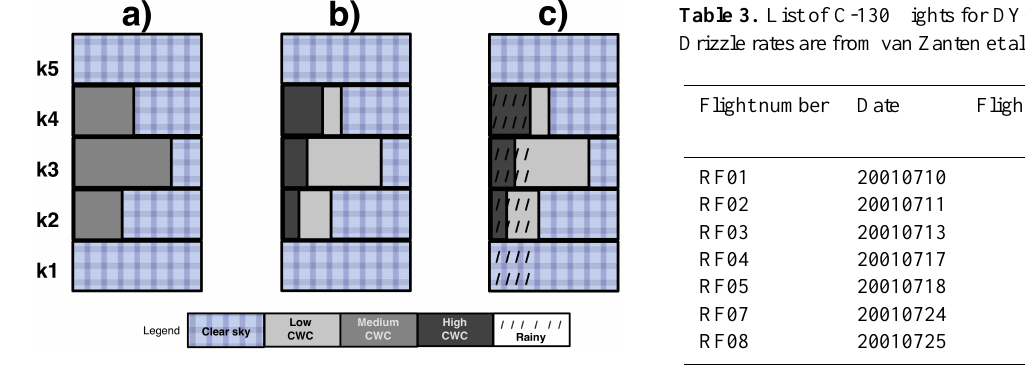
Fig. 3. The three columns are the successive steps of the numerical treatment of the cloud and rain vertical overlap in a model column with 5 levels: k1, k2, k3, k4, and k5. (a) The maximum cloud overlap is applied for adjacent or non-adjacent layers. (b) The same maximum cloud overlap of (a) is applied for the new parameterization using the splitting of the CWC in two regions, and maximally overlapping the high CWC regions. (c) The rain is falling vertically with a maximum vertical overlap.